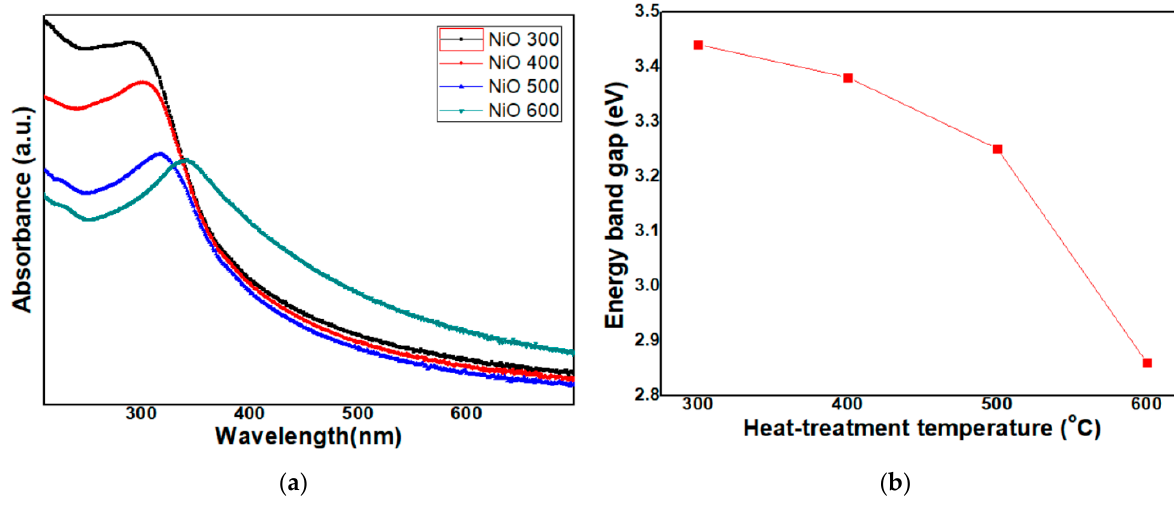
Figure 8. ( a ) UV-vis absorption spectra; ( b ) Energy band gap of NiO NPs heat-treated at 300 °C, 400 °C, 500 °C and 600 °C, respectively.